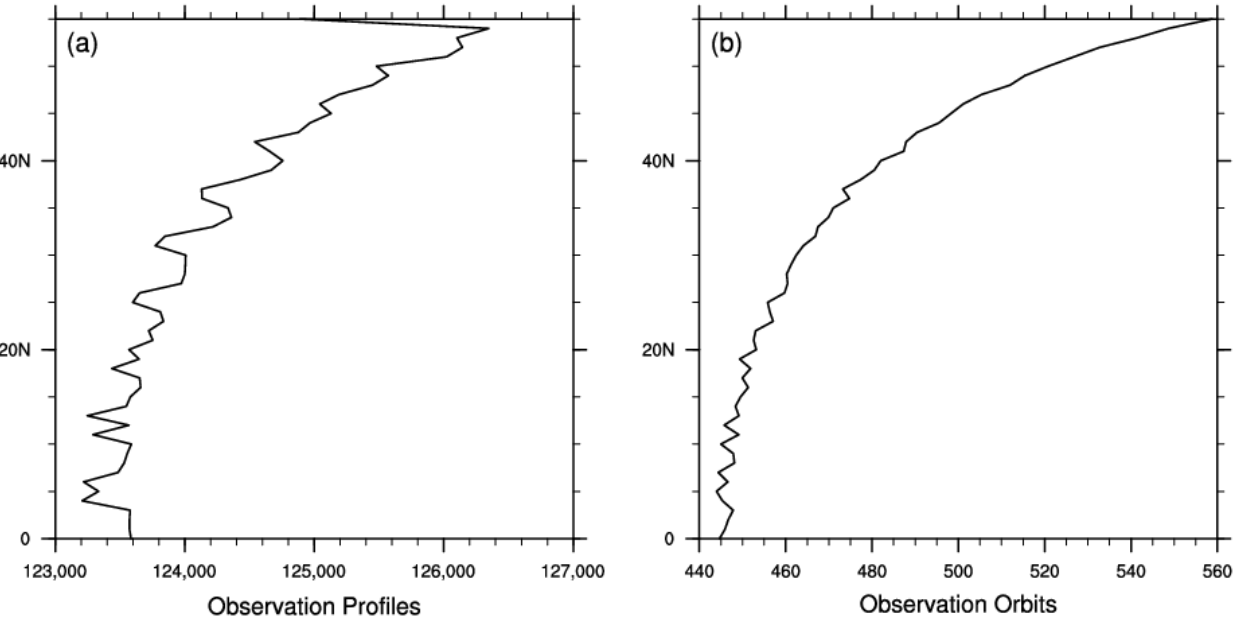
Figure 1. Zonal average sample size over China and its surrounding areas from June 2006 to June 2020. ( a ) Number of observation profiles. ( b ) Number of observed orbits. For ERA5 reanalysis data with 0.25° × 0.25° resolution, we used the nearest neighbor interpolation method to match the 0.25° × 0.25° reanalysis data with the satellite data with